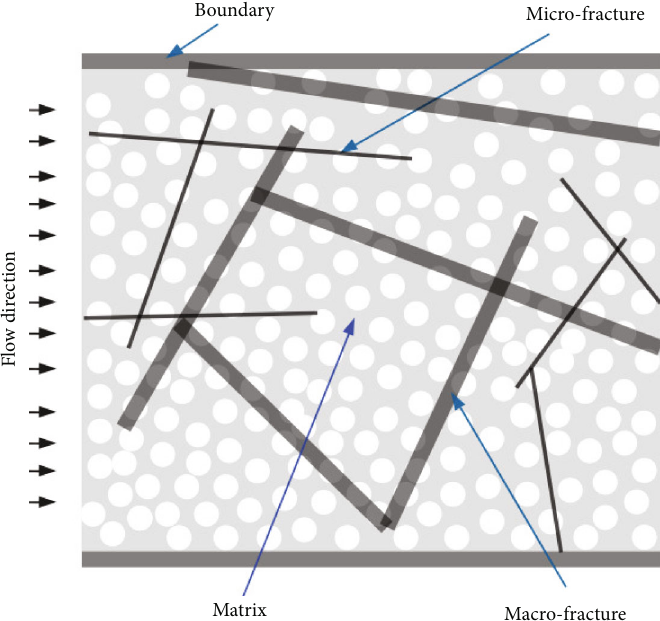
Figure 1: Proposed multiscale naturally fractured porous media model.